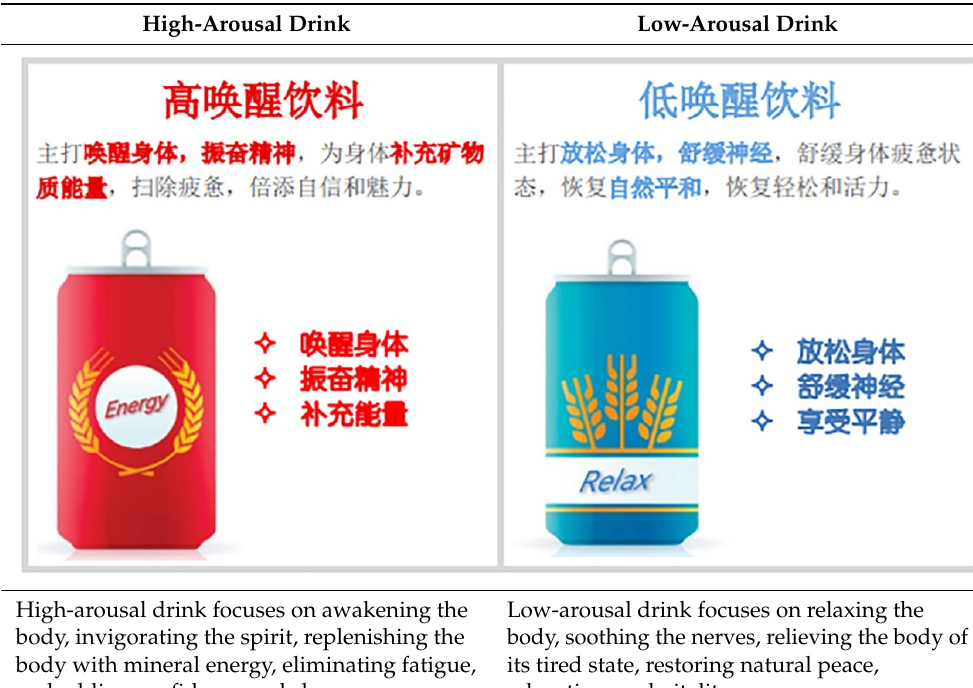
Table A1. Arousal drinks stimuli used in Study 1 and Study 3.